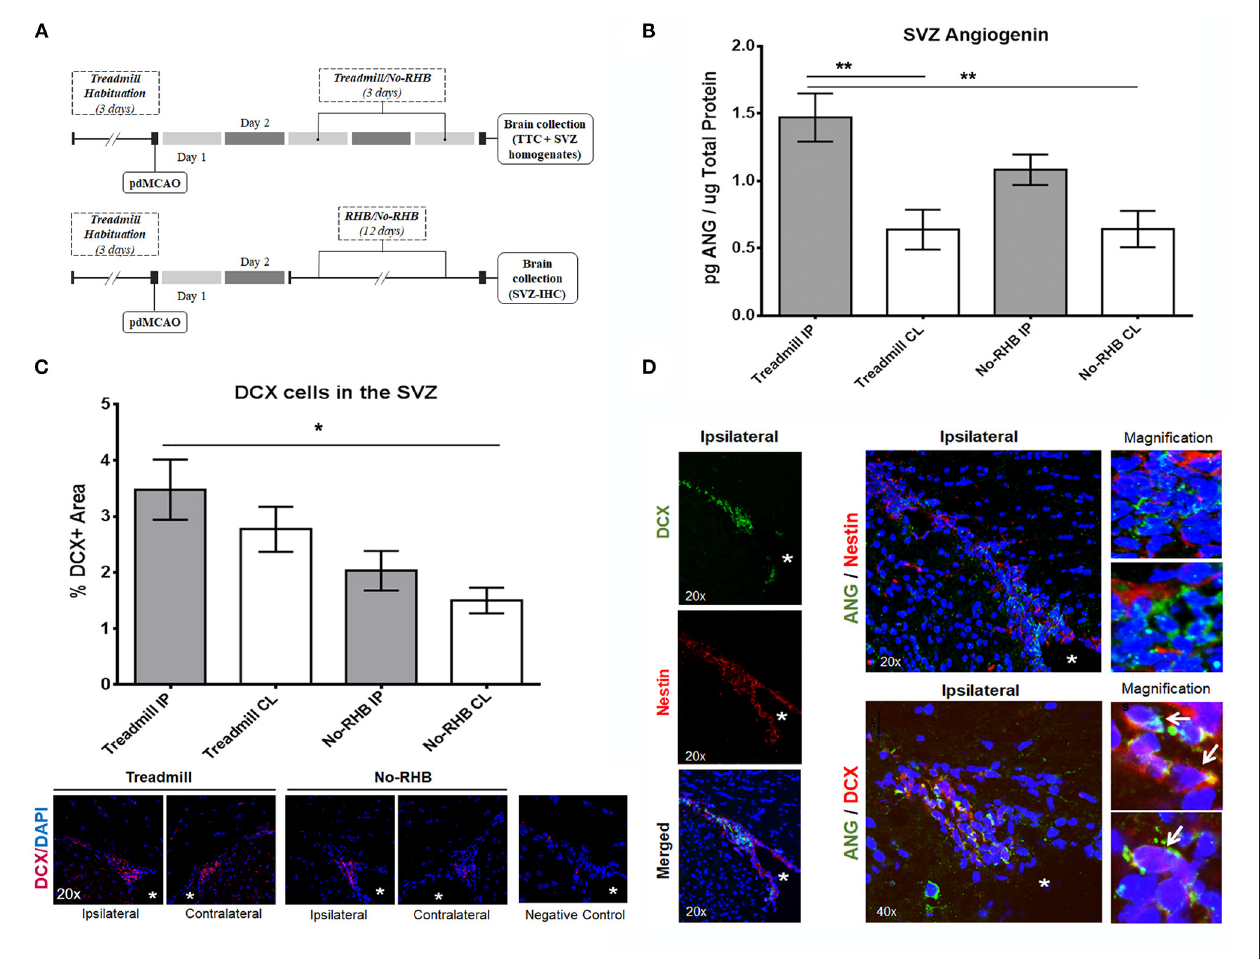
FIGURE 4 | Post-stroke SVZ neurogenesis and angiogenin expression: (A) timeline schemes describing the pre-clinical stroke and treadmill rehabilitation protocols. (B) Bar graph representing angiogenin after 3 days of treadmill rehabilitation or no rehabilitation in the SVZ area, measured by ELISA ( n = 6/group); (C) bar graph representing DCX + quantification in the immunohistochemistry study of the SVZ ( n = 5/group) and representative immunostains of the ipsilateral hemisphere identifying the neuroblasts (DCX + ). (D) Representative immunostains of the SVZ after stroke and treadmill exercise showing the distribution of nestin + and DCX + NSCs in the SVZ (left panel); notice that only neuroblasts (DCX + ) had the most angiogenin expression, which is specifically shown in the insert magnifications and in white arrows. Bar graphs represent mean ± SEM, * p < 0.05 and ** p < 0.01 as indicated by the horizontal lines. ANG, angiogenin; CL, contralateral; DAPI, 4 ′ ,6-diamidino-2-phenylindole; DCX, doublecortin; IP, ipsilateral; RHB, rehabilitation; SVZ, subventricular zone. The white * indicates the position of the lateral ventricle with contiguous dorsolateral